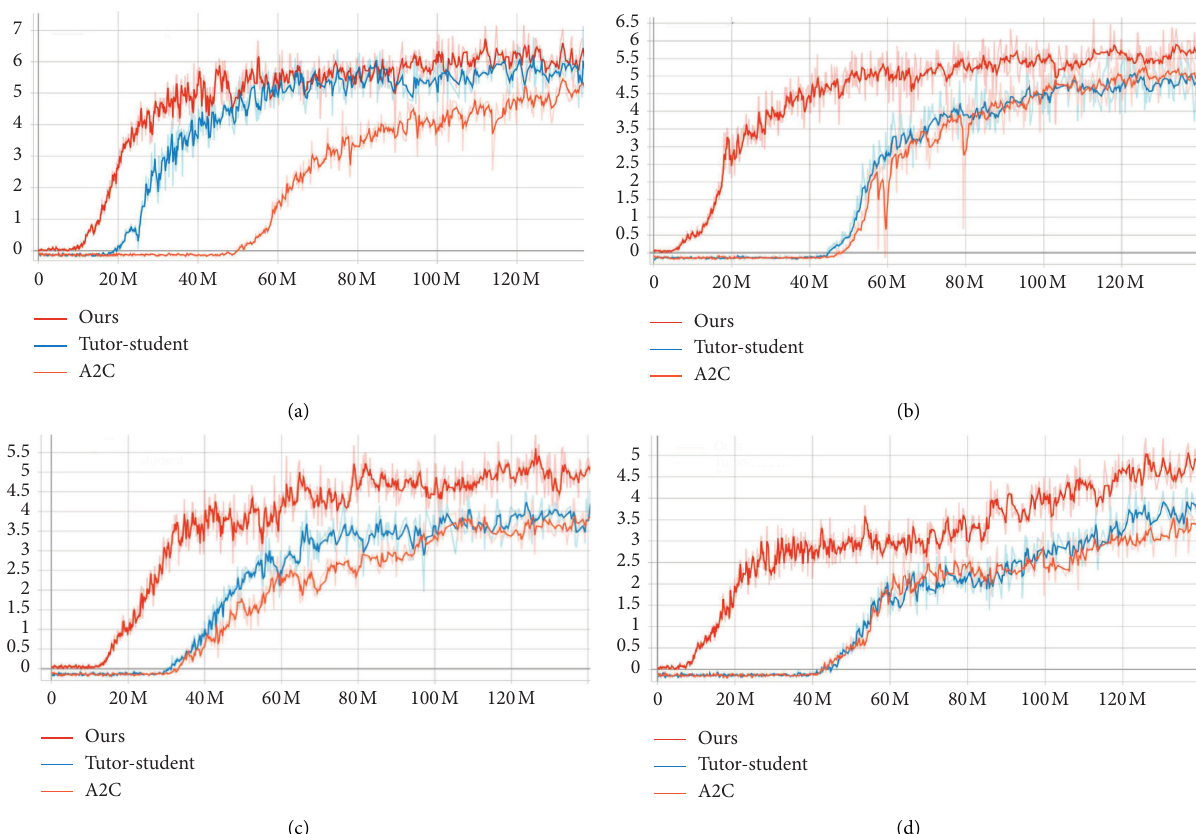
Figure 6: Average reward curves of ours, tutor-student, and A2C model training with different bedroom settings. (a) One-bedroom maze. (b) Two-bedroom maze. (c) Three-bedroom maze. (d) Four-bedroom maze.